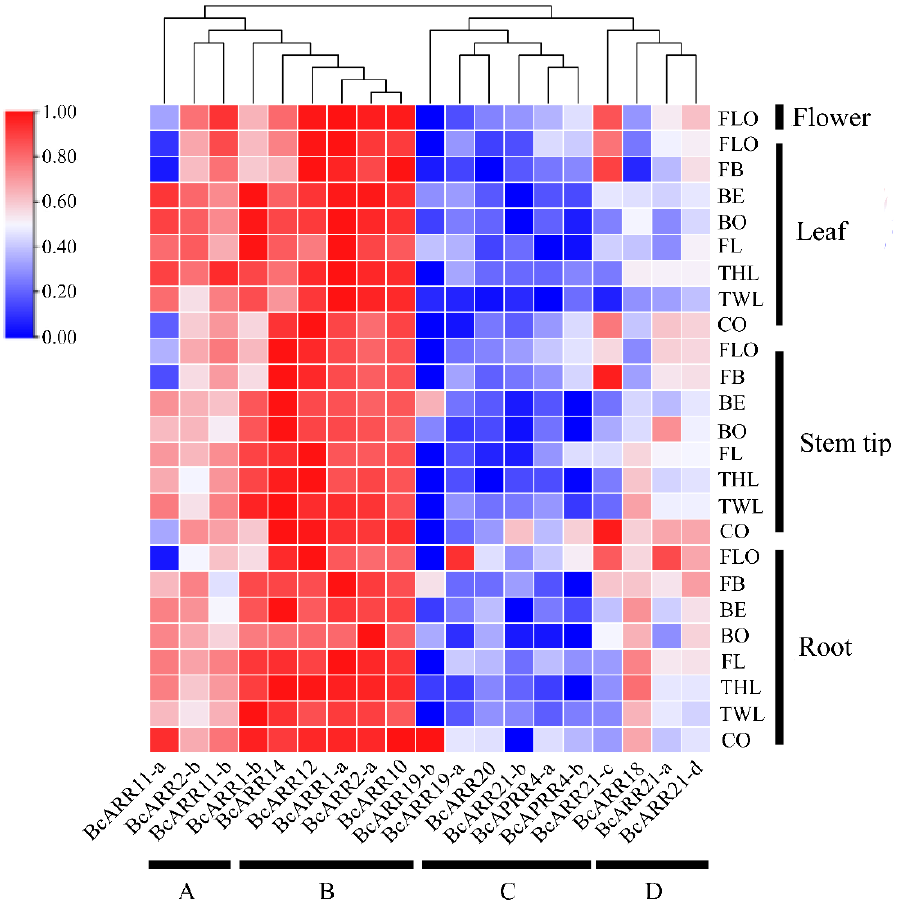
Figure 11. Heatmap of BcARR-B genes transcribed in the tissues of flowering Chinese cabbage at different development stages. CO, cotyledon stage; TWL, two-leaf stage; THL, three-leaf stage; FL, four-leaf stage; BO, bolting stage; BE, bud emergence stage; FB, fast bolting stage; FLO, flowering stage.